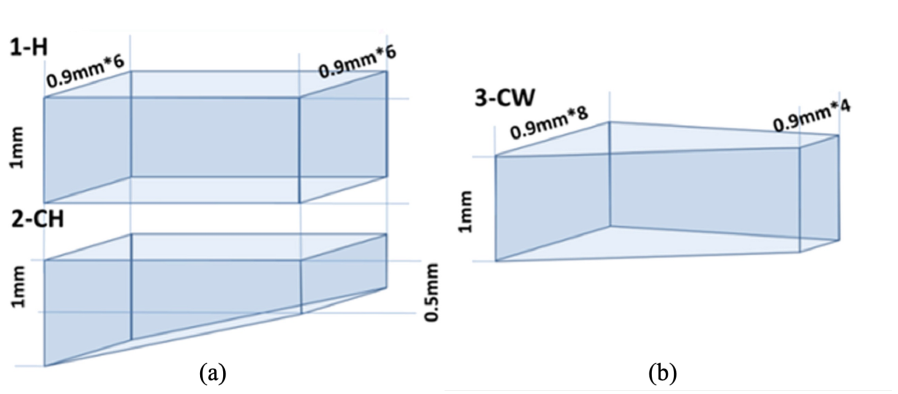
Figure 16. The conical flow fields: ( a ) gradually reduced height; ( b ) gradually reduced width [73]. Jia et al. [74] changed the flow channel wall of the serpentine flow field to a wavy